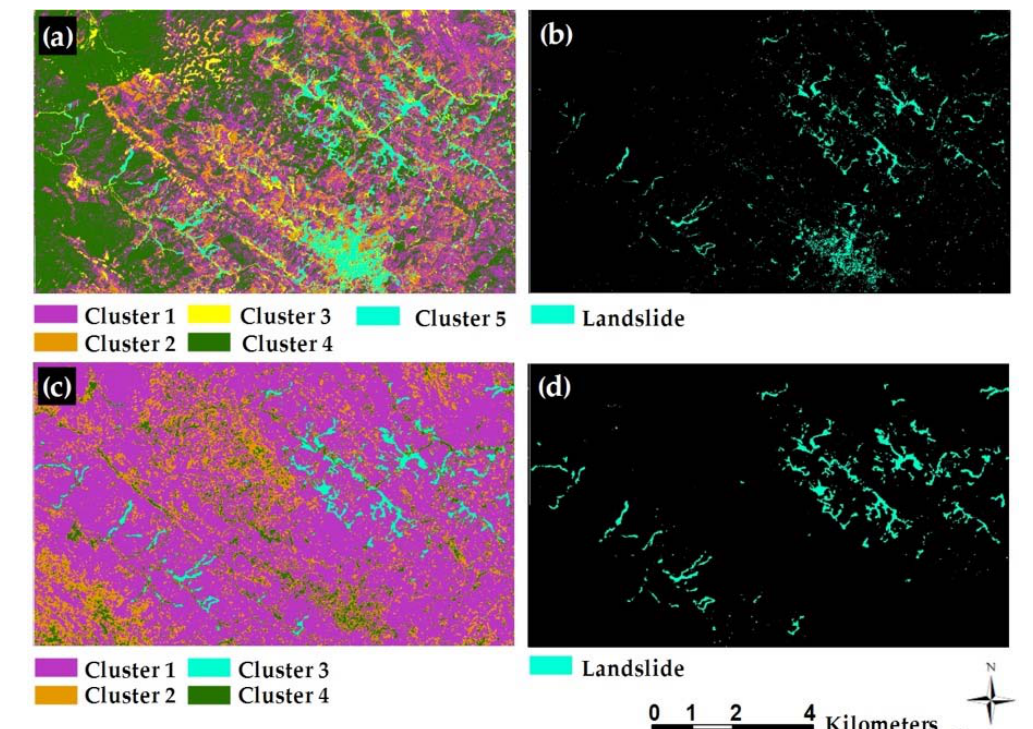
Figure 12. Clustering landslides in India’s case study. ( a , b ) Clustering and binary landslide map based on MNF features, slop, and NDVI, while ( c , d ) show the same features as well as the deep features.